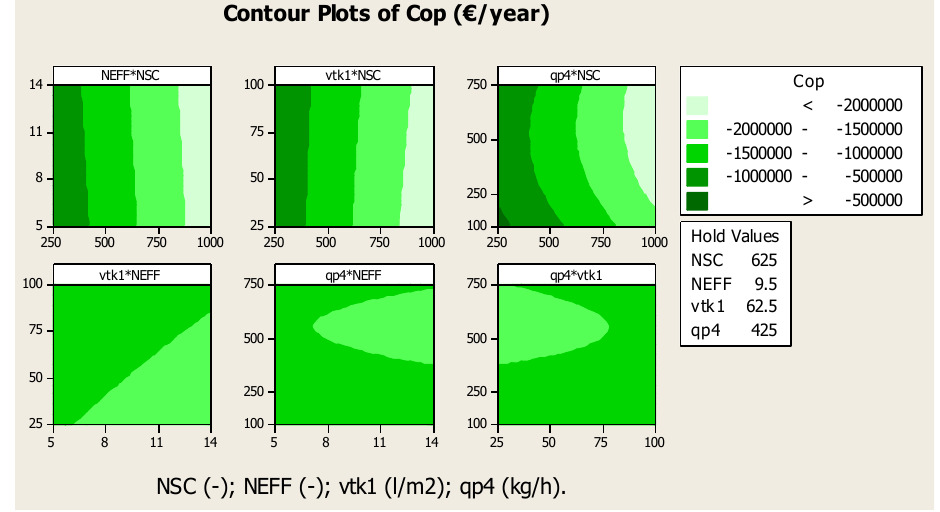
Figure 10. Contour plots of C op .